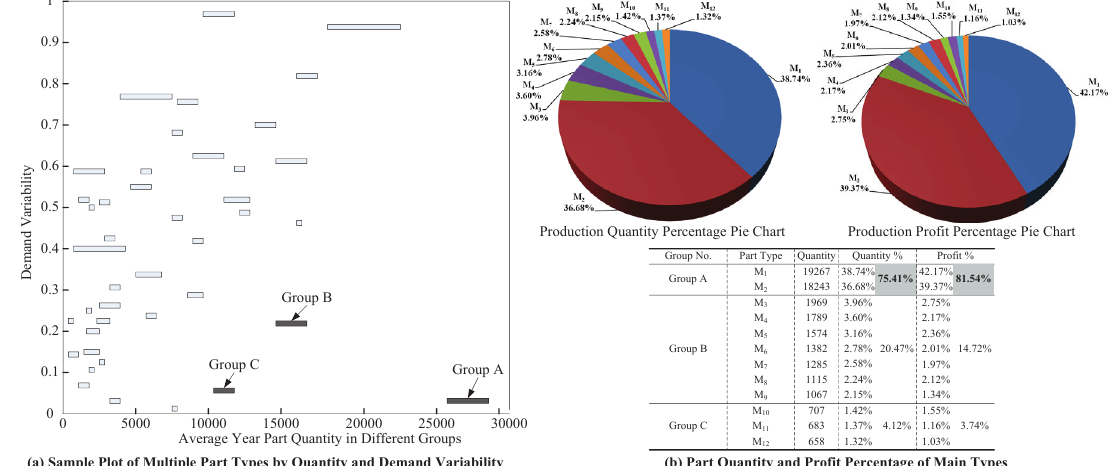
(b) Part Quantity and Profit Percentage of Main Types(a) Sample Plot of Multiple Part Types by Quantity and Demand Variability